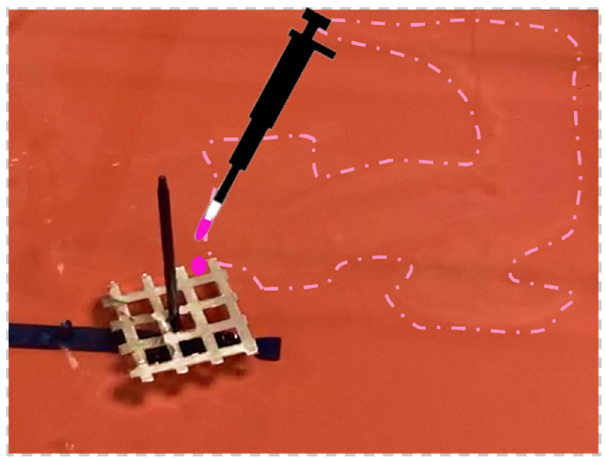
Figure 5. Al square grid forms an extended polymeric layer; the expanded film stops the grid’s rotation. On-the-fly formed polymeric film is indicated by the dotted line. rotation. On-the-fly formed polymeric film is indicated by the dotted